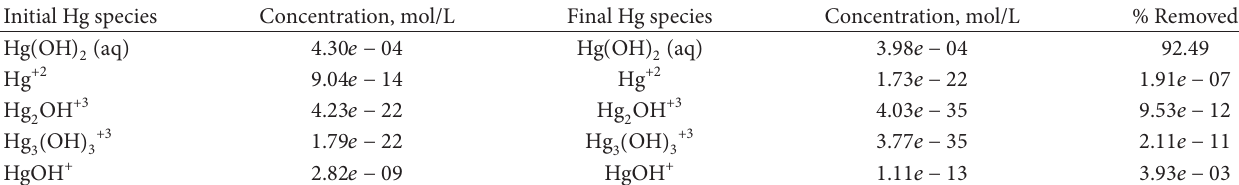
Table 2: Modeling of Hg speciation using Visual MINTEQ 3.0 for EK-GAC-1.